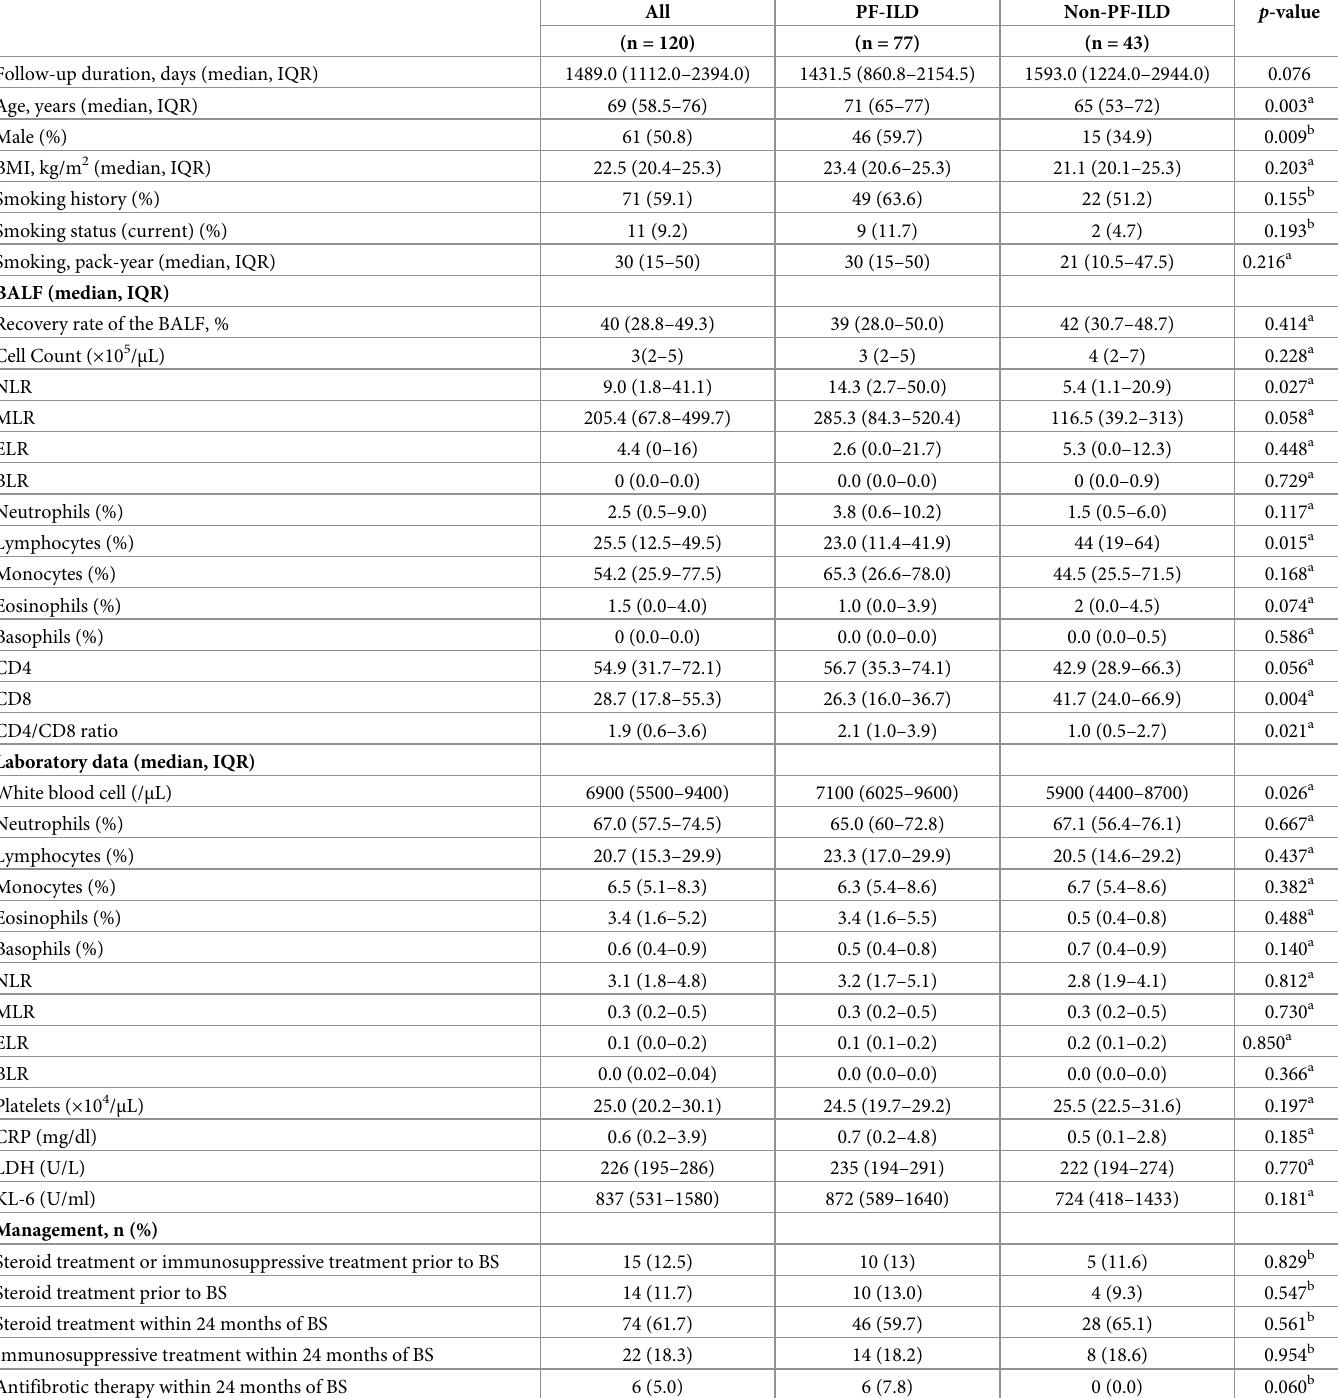
Table 1. Baseline characteristics of the study